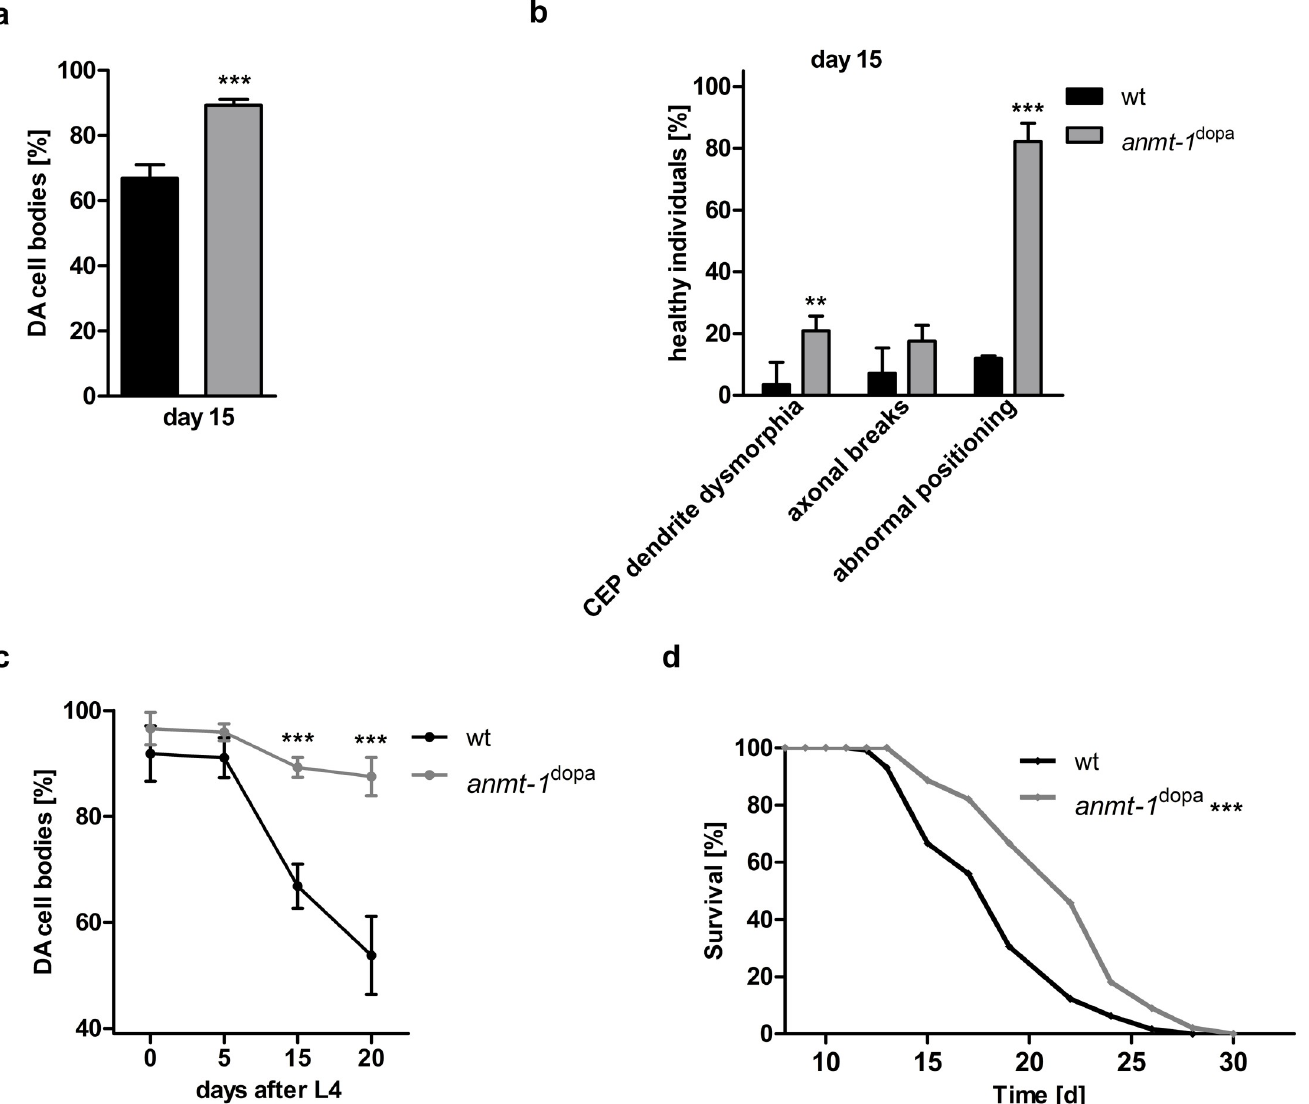
Fig 1. anmt-1 expression in the dopamine system influences neurodegeneration and lifespan. a Presence of dopaminergic (DA) cell bodies in wt (black) and anmt-1 dopa (grey) at day 15 of adulthood. b DA neuronal morphology categorized in CEP dendrite dysmorphia, axonal breaks, and abnormal cell body and axon positioning in percentage of healthy individuals of wt and anmt-1 dopa at day 15 of adulthood. Note that the percentage of healthy worms regarding the different anomalies was depicted for easier comparison, so that in both the cell body and morphology graphs a completely healthy population equals 100%, and a completely sick population equals 0%. c DA cell body presence in wt and anmt-1 dopa at different ages. d Lifespan analysis of anmt-1 dopa compared to wt. �� : p < 0.01, ��� : p <